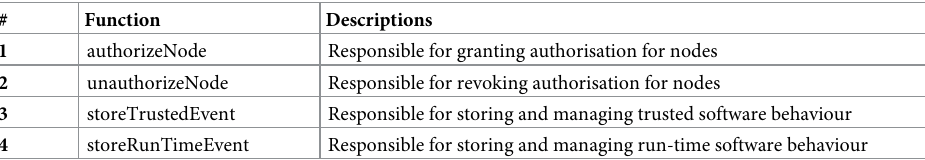
Table 1. System smart contracts’ main